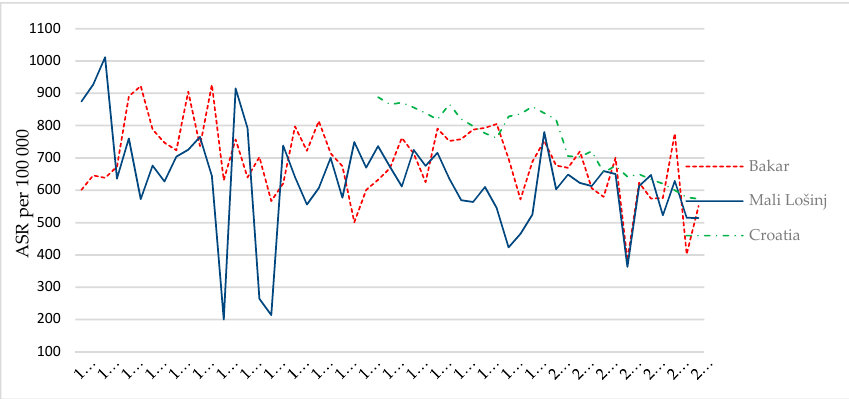
Figure 2. Age-standardised mortality rate in the towns of Bakar and Mali Lošinj in the period 1960–2012/100,000 population.